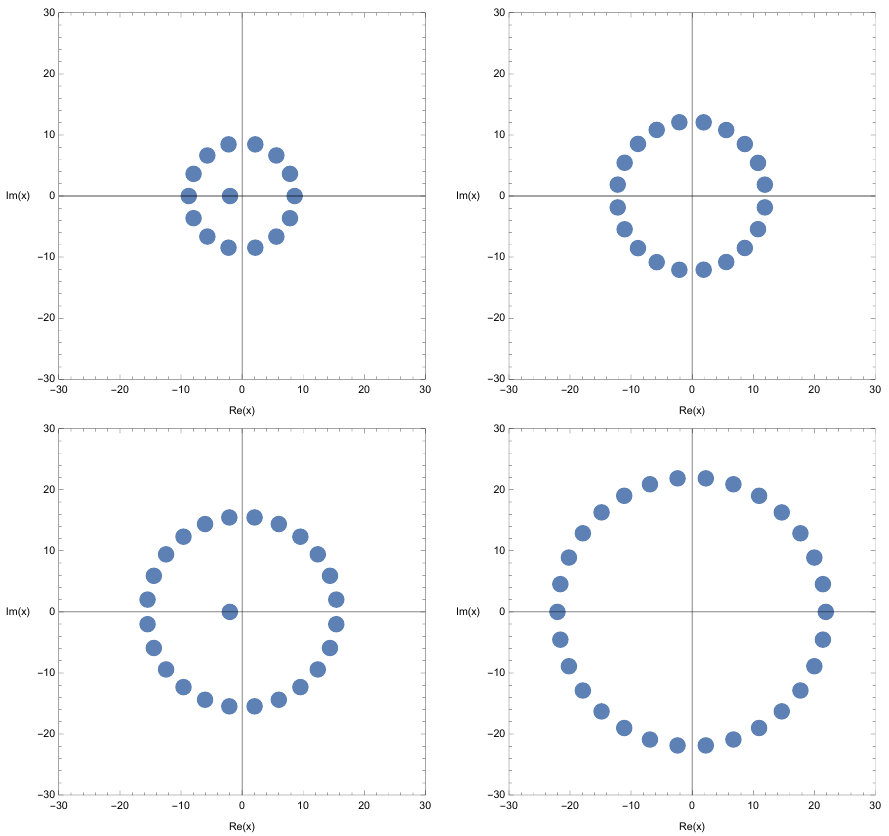
Figure 1. Stacking structure of approximation roots in ( p , q ) -cosine geometric polynomials when n = 15,20,25,30, p = 1 , q = 1 , y = 3 and z = 2 10